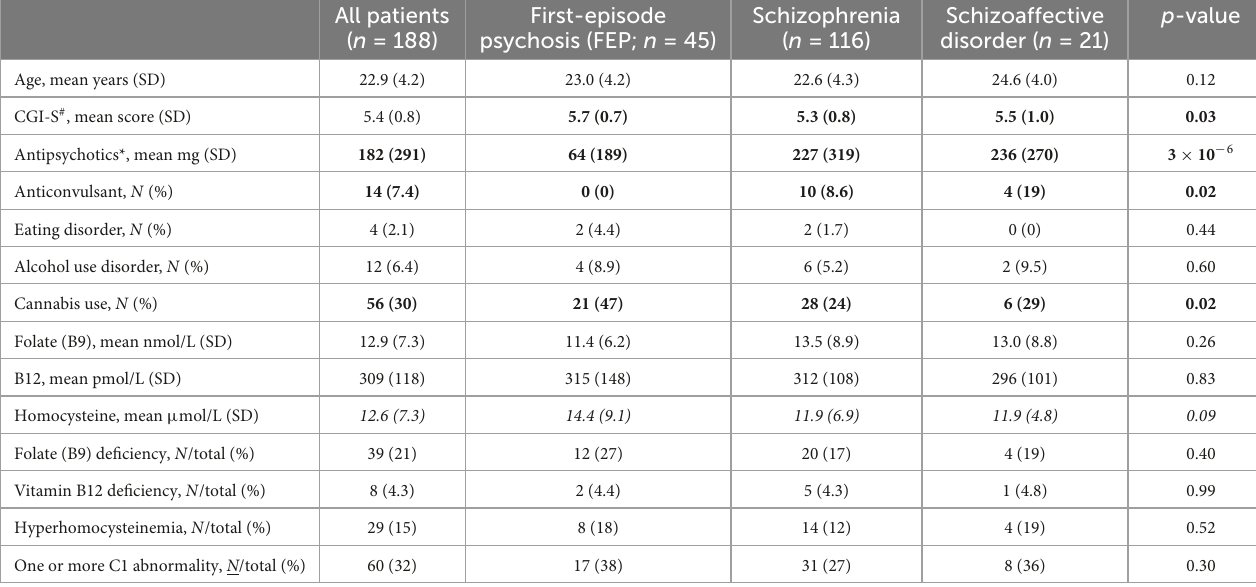
TABLE 1 Clinical and biological characteristics of the whole sample and according to diagnosis.